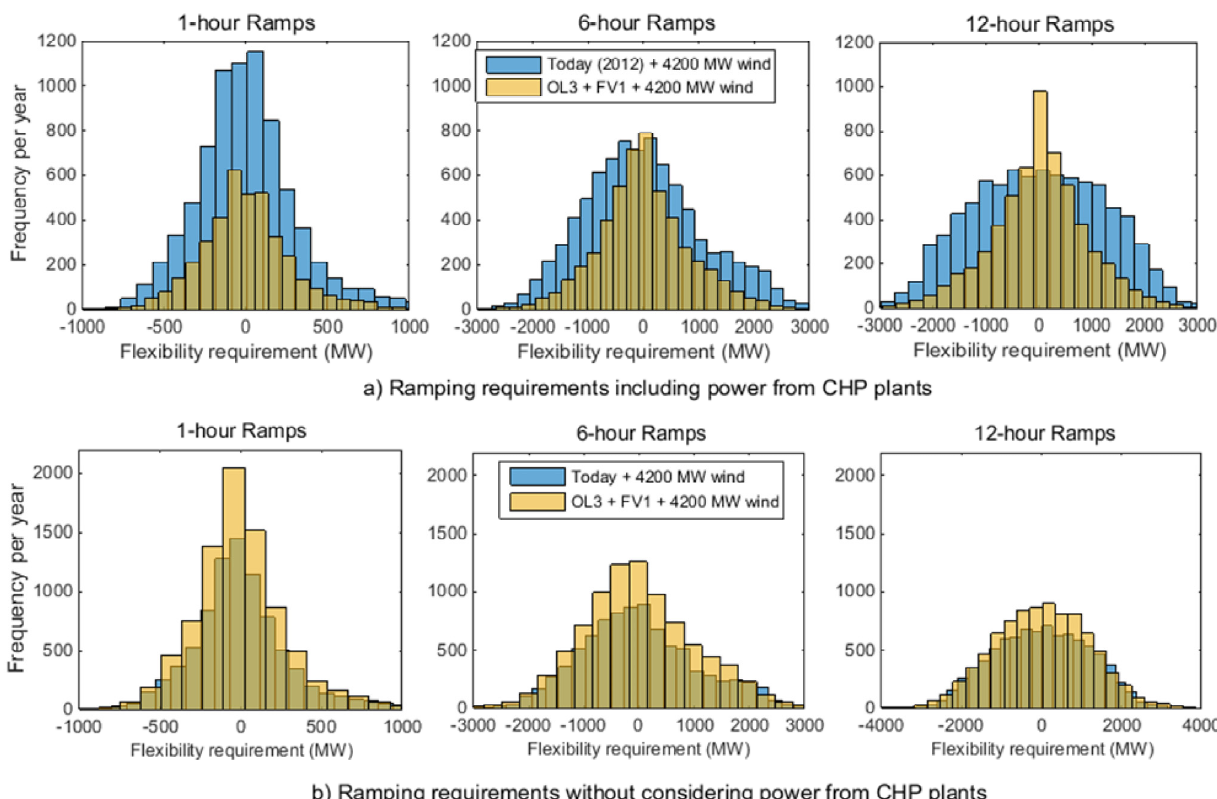
Figure 11. The frequency and magnitude of 1-, 6-, and 12-h ramps in net power load after adding 4200 MW wind installations, ( a ) with power from CHP and ( b ) without power from CHP. The case is compared for today (blue) and after two new NPPs in Case I (yellow), with fixed power demand (85